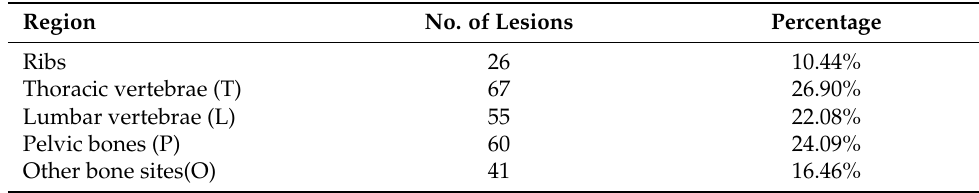
Table 2. Lesion localization.